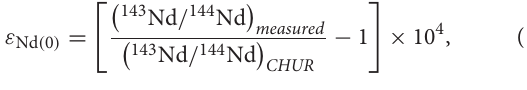
U Numbers correspond to those given on Figure 1